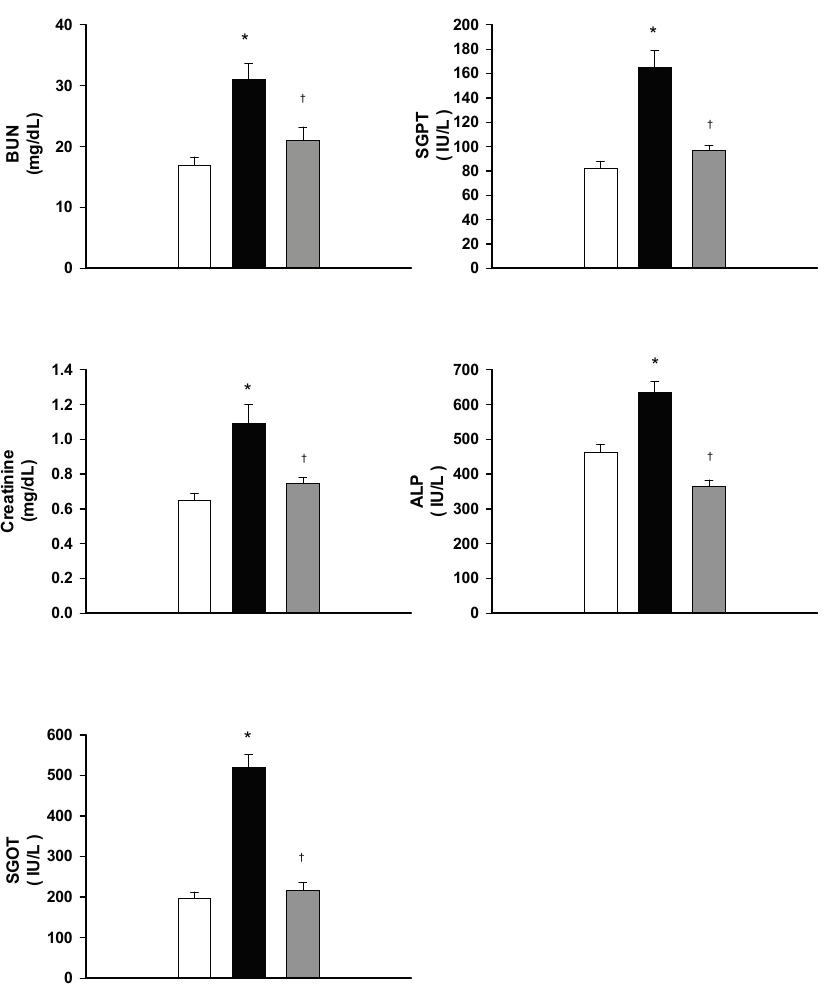
Figure 3. Effects of heat exposure (43 °C) on plasma levels of BUN, creatinine, SGOT, SGPT, and ALP in normothermic control rats (white bar), saline-treated (black bar)